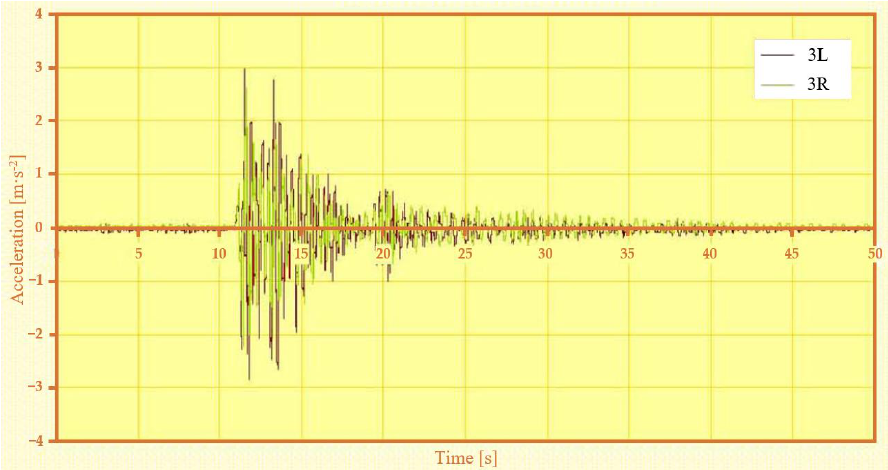
Figure 20. Vertical acceleration in the middle of the car body on the left and right side—variant B-III.